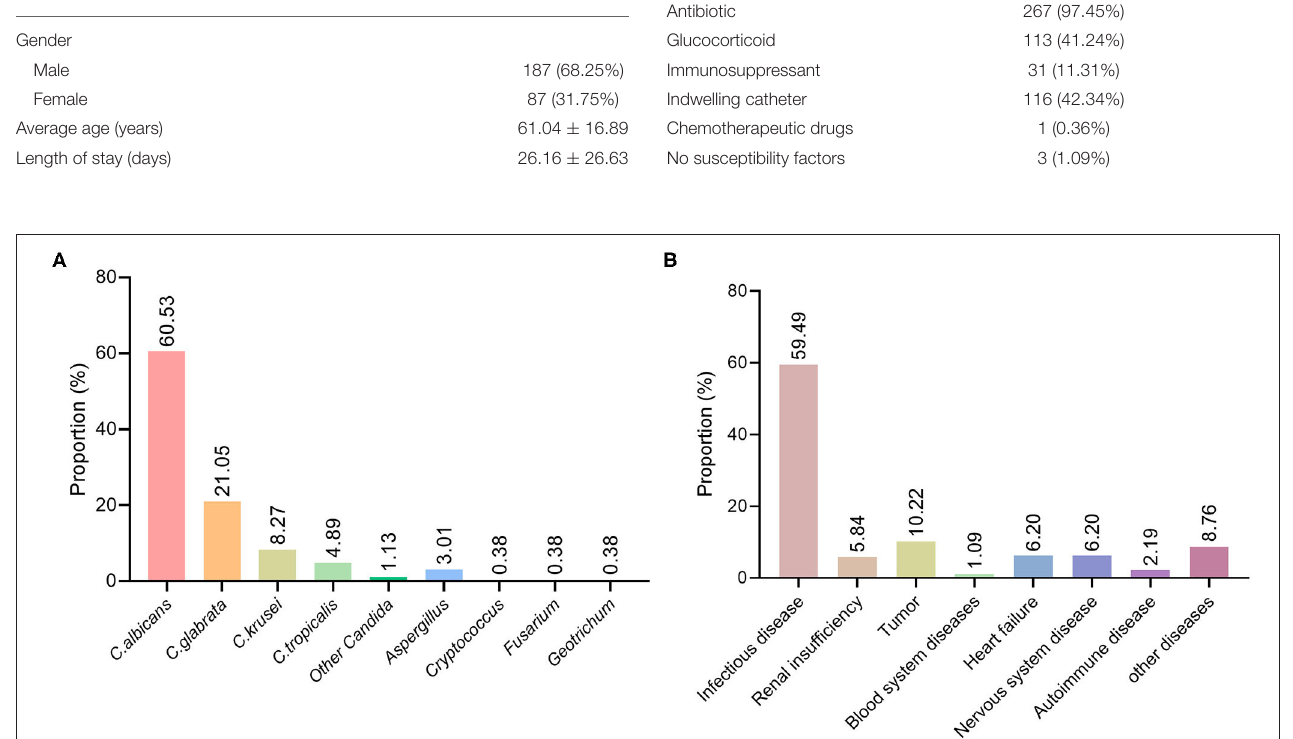
FIGURE 2 | Distribution of pathogenic fungi and basic diseases in patients with deep fungal infections. (A) Distribution of various fungal species in patients with deep fungal infections. (B) Distribution of underlying diseases in patients with deep fungal infections.